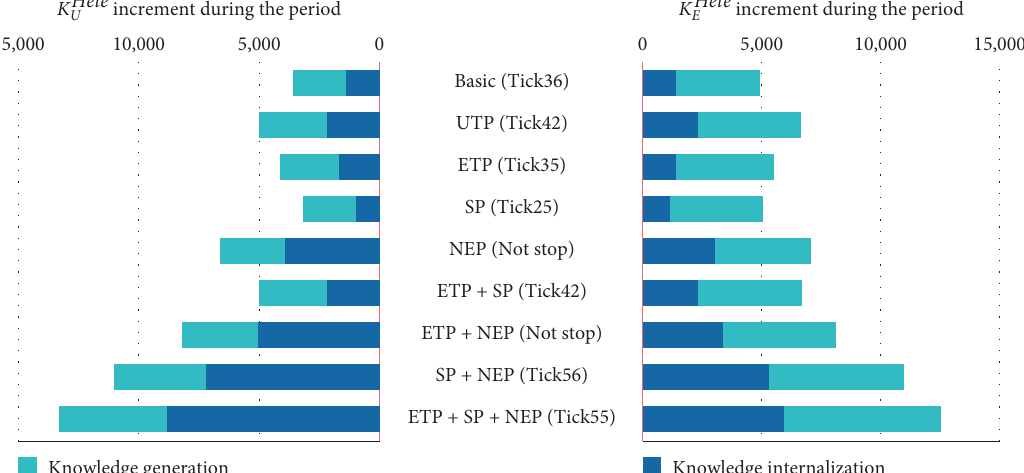
Figure 9: The trend of heterogeneous knowledge increment of innovation subjects in multi-scenarios.